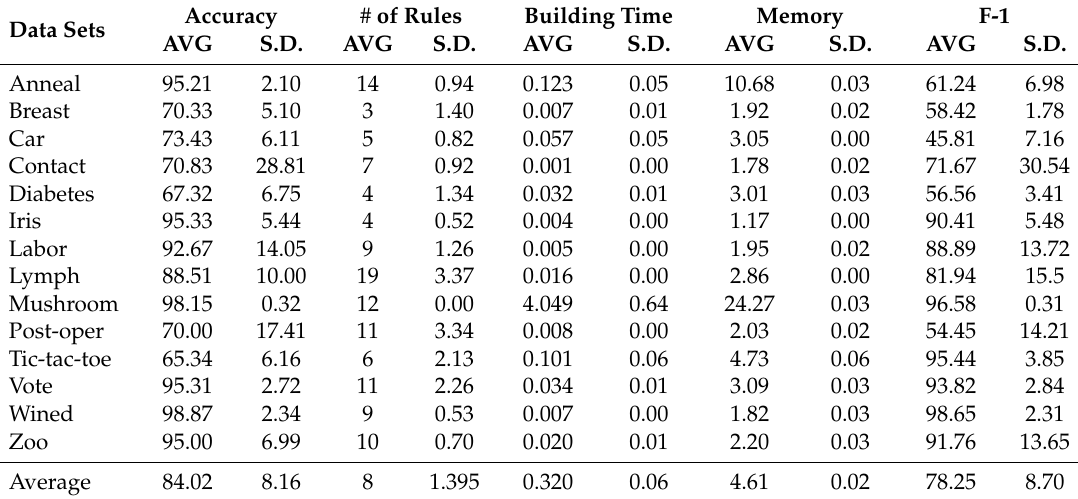
Table 15. Standard deviations of